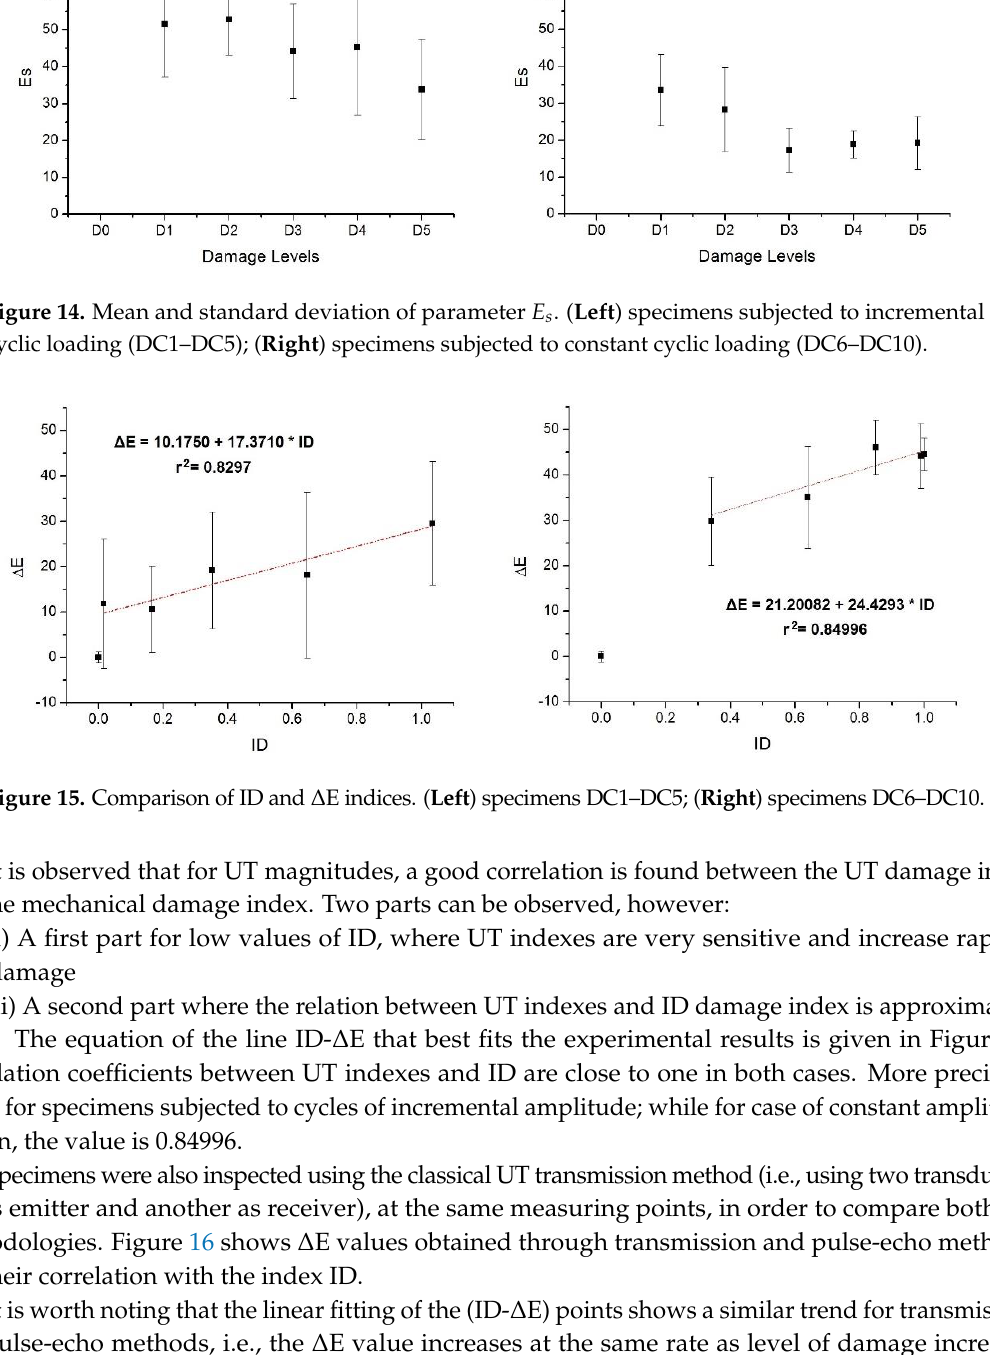
11 of 14 Figure 13. Typical hysteresis curves obtained from the tests of specimens DC6 to DC10. Table 3 Mechanical index of damage ID. Specimen